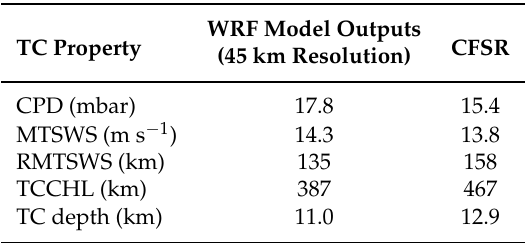
Table 3. Mean value of TC properties in the WRF model outputs and in the Climate Forecast System Reanalysis (CFSR) for 2005–2017. CPD: central pressure deficit, MTSWS: maximum tangential surface wind speed, RMTSWS: radius of